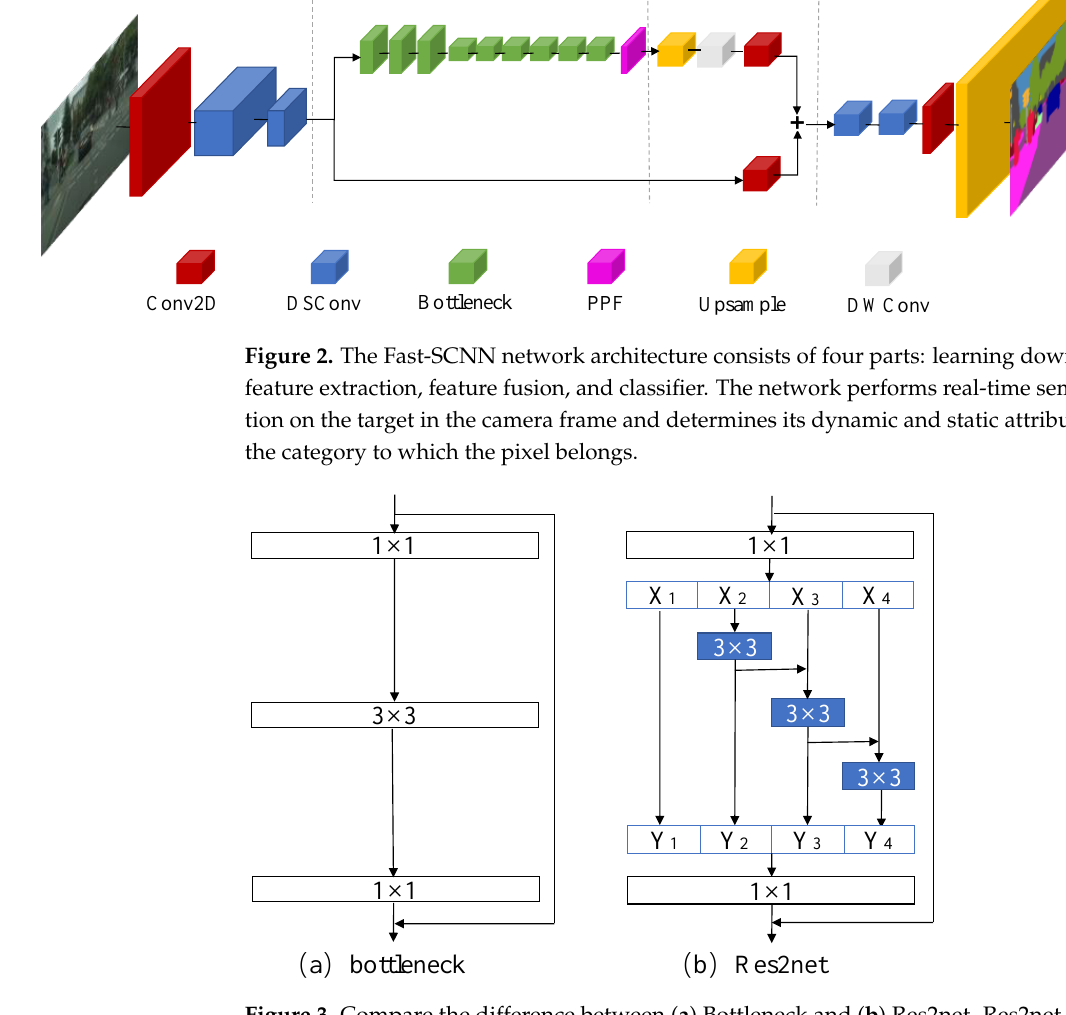
Figure 2. The Fast-SCNN network architecture consists of four parts: learning down sample, global feature extraction, feature fusion, and classifier. The network performs real-time semantic segmen-